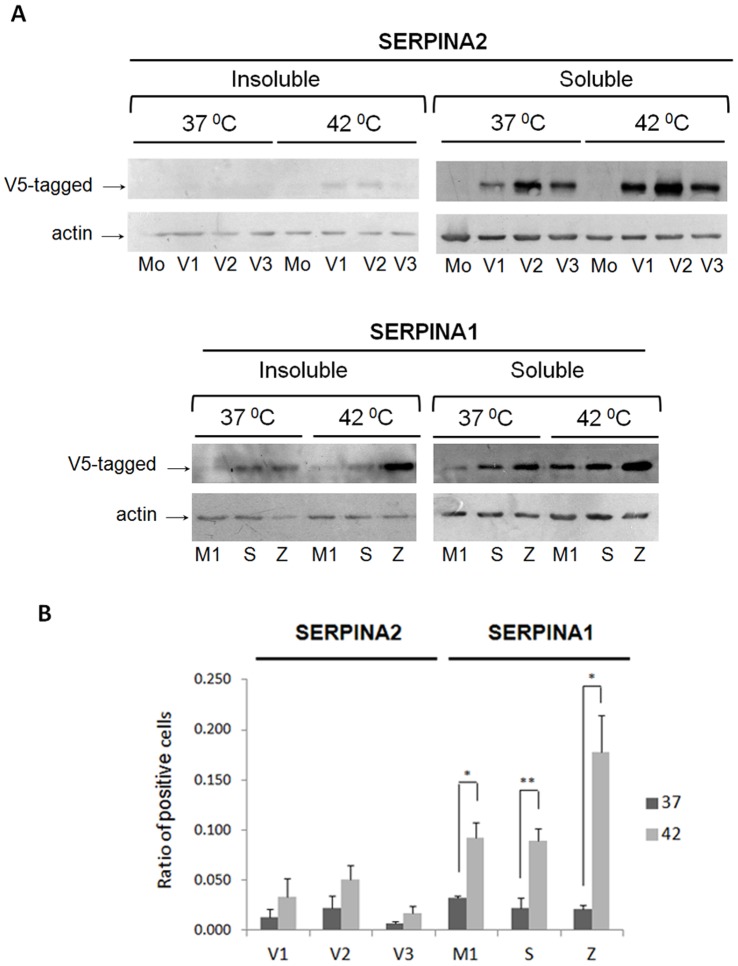
Protein polymerization and heat stress response.HeLa cells stably expressing SERPINA2 and A1 were incubated for 24 hours at 37 or 42 °C. A - Insoluble and Soluble protein extracts were separated by 10% SDS-PAGE. SERPINA2 and A1 were detected with anti-V5 and actin was used as loading control. B - Number of cells stained with V5 antibody were quantified and presented graphically; n = 3; mean+SD; *p<0.05; **p<0.01.